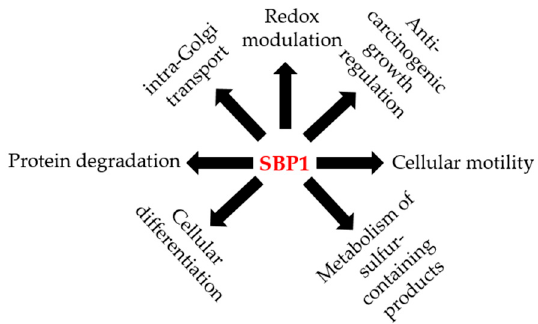
Figure 2. The potential roles of SBP1 in human health and disease. Illustration of the different potential functions reported for SBP1 in the published literature.